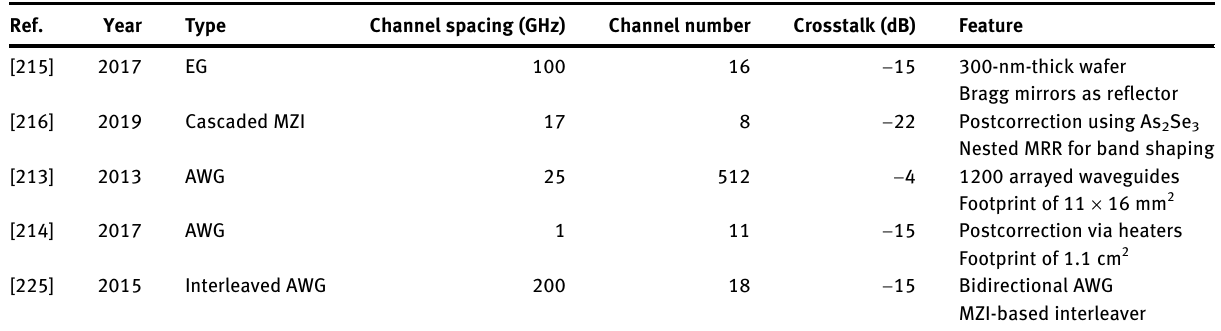
Table  : Brief survey of FIR fi lters demonstrated on SOI.